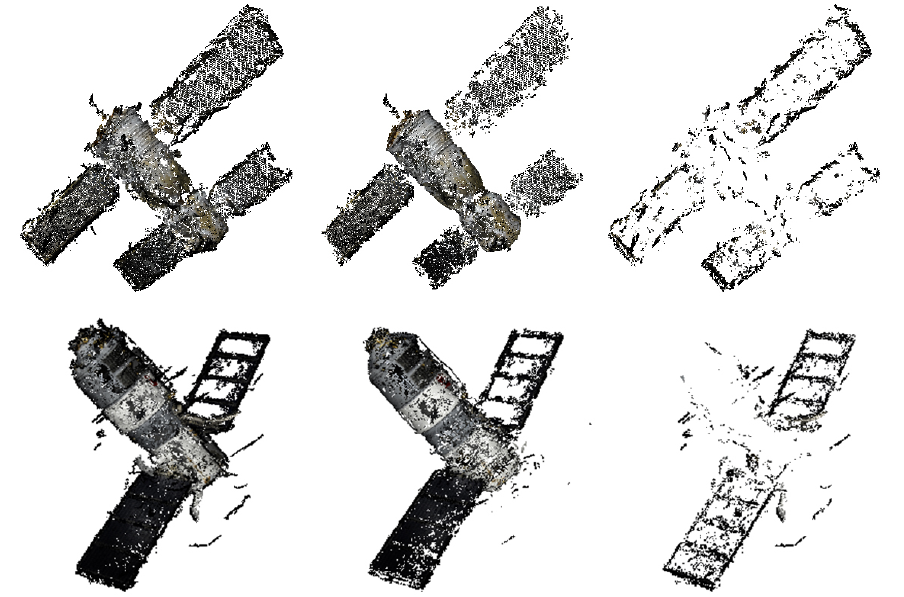
Figure 12. Results of reconstruction and refinement for Shenzhou-6 and Tiangong-1. From left to right: the recovered point cloud, the point cloud after being refined and points filtered by refinement.